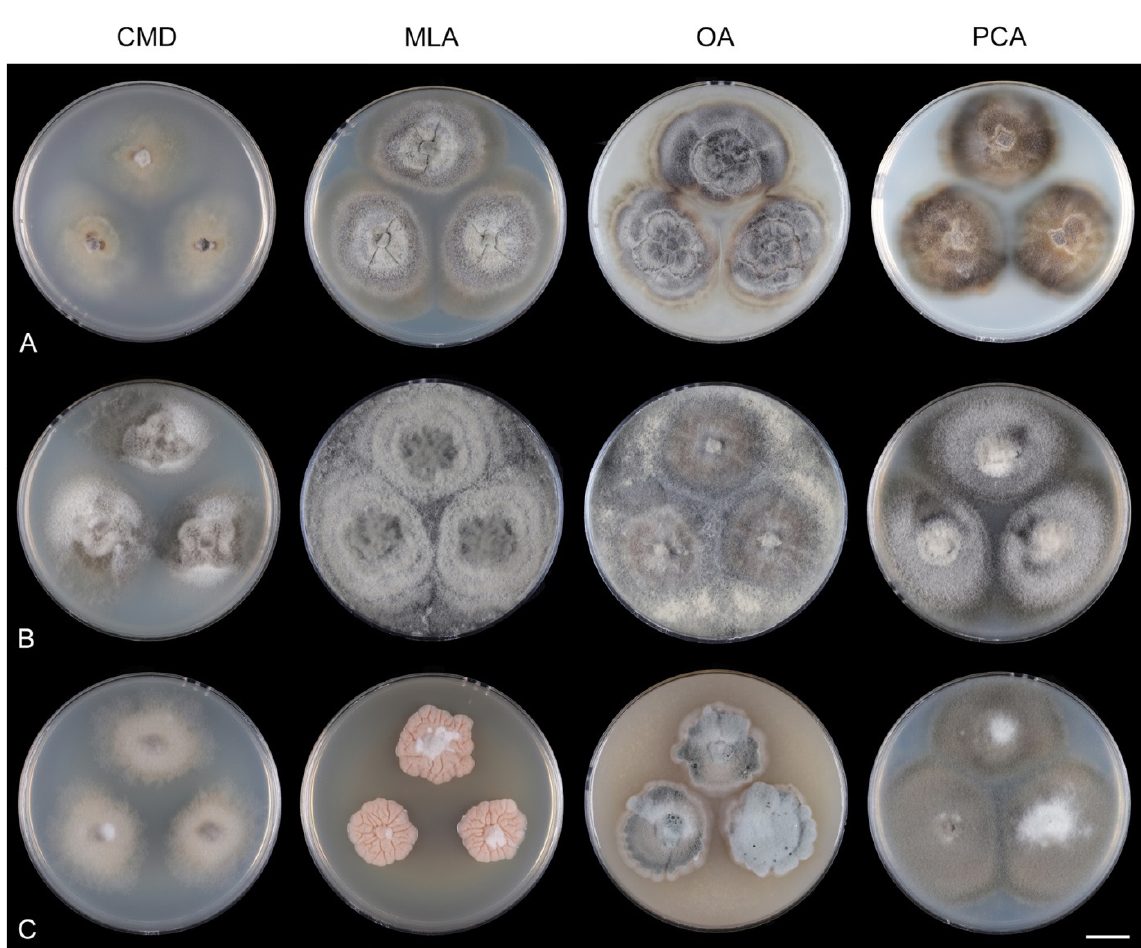
Figure 11. Colony morphology of Codinaea spp. after 4 weeks. ( A ) C. amazonensis MUCL 41171 ( B ) C. gonytrichodes CBS 593.93 ( C ) C. phasma CBS 147516 ex-type. Scale bar: ( A – C ) 1 cm.